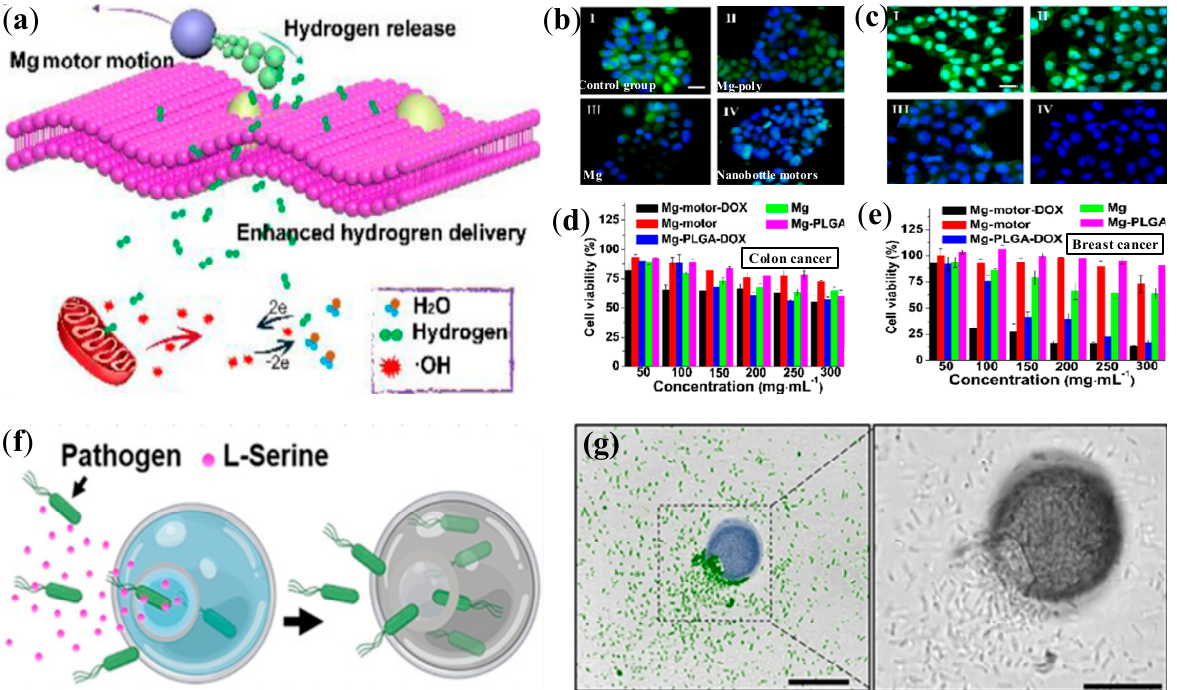
Figure 10. ( a ) Nanobottle motors scavenge intracellular reactive oxygen species. ( b , c ) CellROX detect reactive oxygen species in the cell. ( d , e ) Cell survival rate of cancer cell line with five kinds of treatments. The scale bare is 20 µ m. Reprinted with permission from Ref. [39]. Copyright 2020, copyright Elsevier Ltd. ( f ) Chemoattractant release and pathogen capture in the hollow cavity. ( g ) The chemotactic of pathogen (green) around nanobottle motor (blue). The scale bar is 15 mm. Reprinted with permission from Ref. [118]. Copyright 2019, copyright Wiley-VCH GmbH.